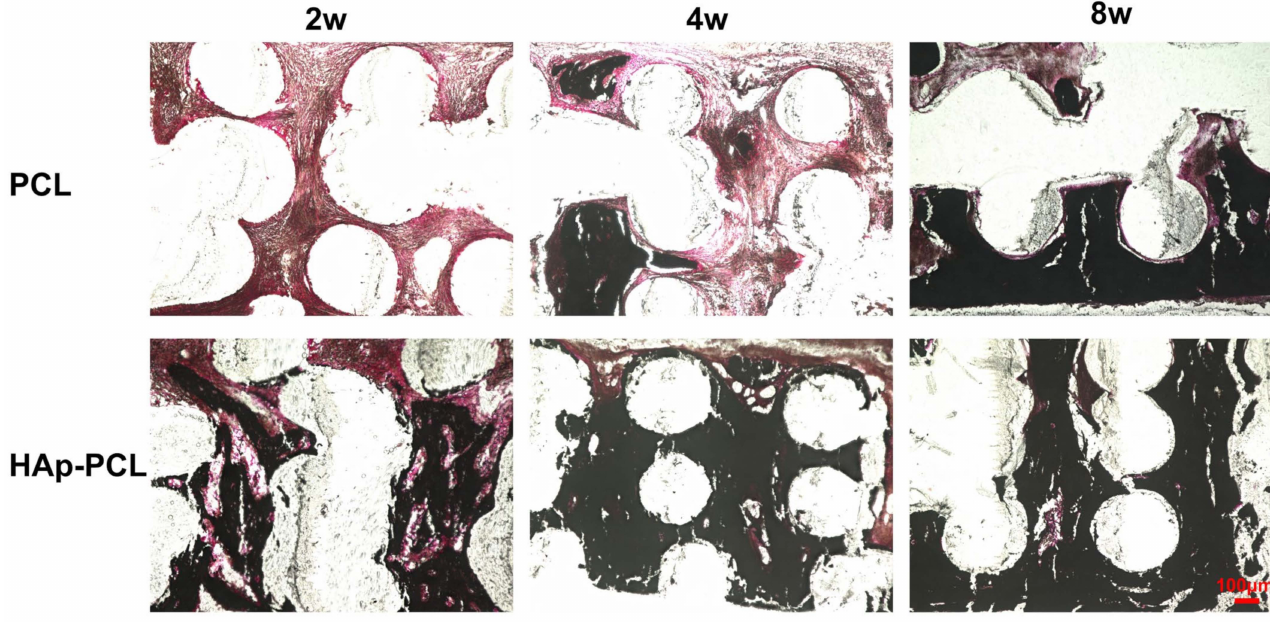
Figure 8. Von Kossa staining for the sectioned tissue inside the scaffold at 2, 4, and 8 weeks af- ter implantation of PCL or HAp-PCL into the critical-sized bone defect in rats. The tissues were counterstained with Nuclear Fast Red solution. Scale bar was 100 µ